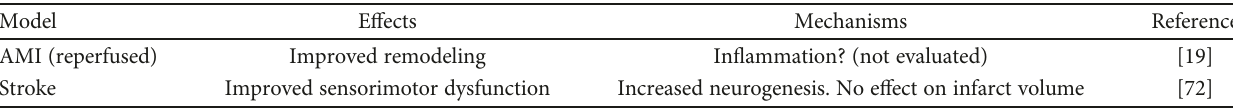
Table 2: E ff ects of Gal-1 treatment on cardiovascular